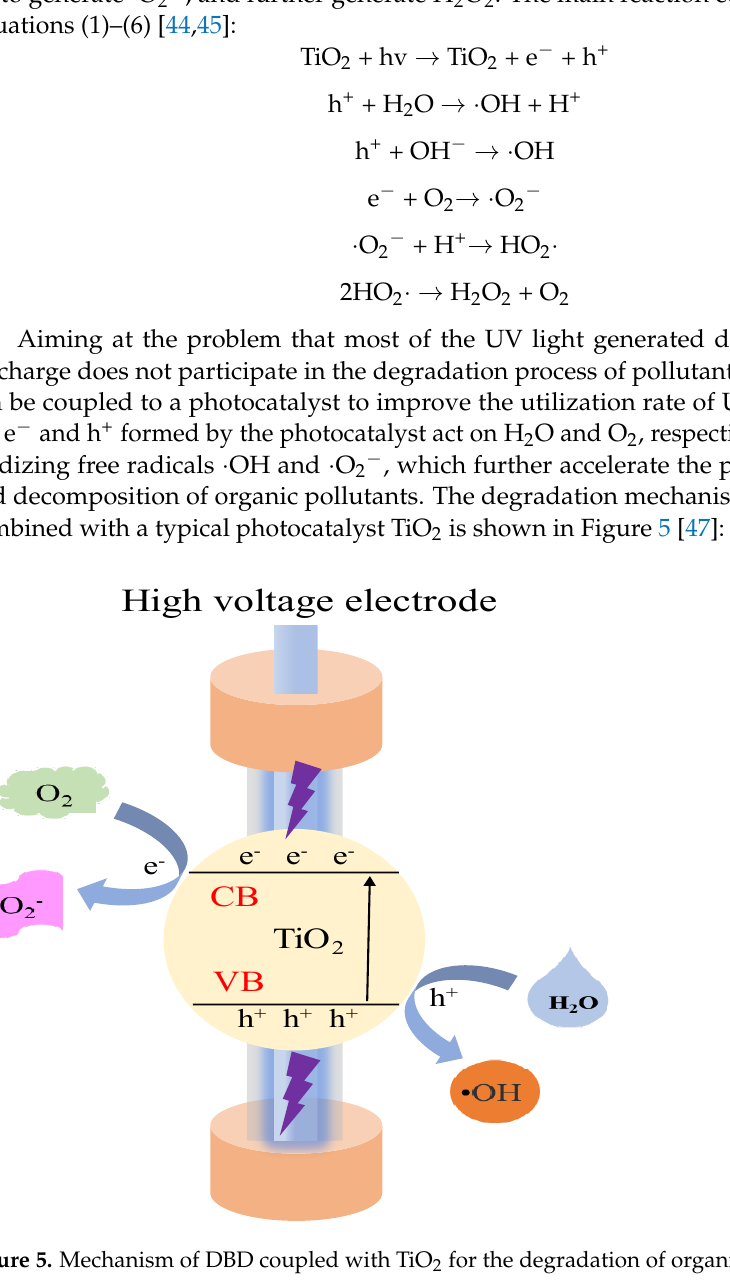
2 for the degradation of organic